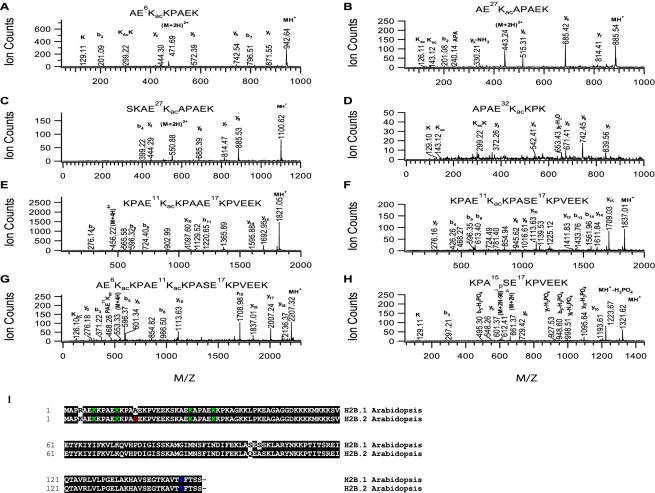
Identification of H2B modification sites.A. MS/MS spectrum of the doubly-charged precursor ion at m/z 471.69 showing H2B acetylation site at K6 in the peptide AE6KacKPAEK. B. MS/MS spectrum of the doubly-charged precursor ion at m/z 443.24 showing H2B acetylation site at K27 in the peptide AE27KacAPAEK. C. MS/MS spectrum of the doubly-charged precursor ion at m/z 550.88 for determining H2B acetylation site at K27 in the peptide SKAE27KacAPAEK. D. MS/MS spectrum of the triply-charged precursor ion at m/z 304.15 for determining H2B acetylation site at K32 in the peptide APAE32KacKPK. E. MS/MS spectrum of the quadruply-charged precursor ion at m/z 456.01 for determining H2B.1 acetylation site at K11 in the peptide KPAE11KacKPAAEKPVEEK. F. MS/MS spectrum of the quadruply-charged precursor ion at m/z 460.01 for determining H2B.2 acetylation site at K11 in the peptide KPAE11KacKPASEKPVEEK. G. MS/MS spectrum of the quadruply-charged precursor ion at m/z 552.70 for determining H2B.2 acetylation sites at K6 and K11 in the peptide AE6KacKPAE11KacKPASEKPVEEK. H. MS/MS spectrum of the doubly-charged precursor ion at m/z 661.37 for determining H2B.2 phosphorylation site in the peptide KPA14
pSEKPVEEK. I. Sequence alignment of Arabidopsis H2B (H2B.1 and H2B.2). K in green color: acetylation; S in red color: phosphorylation.